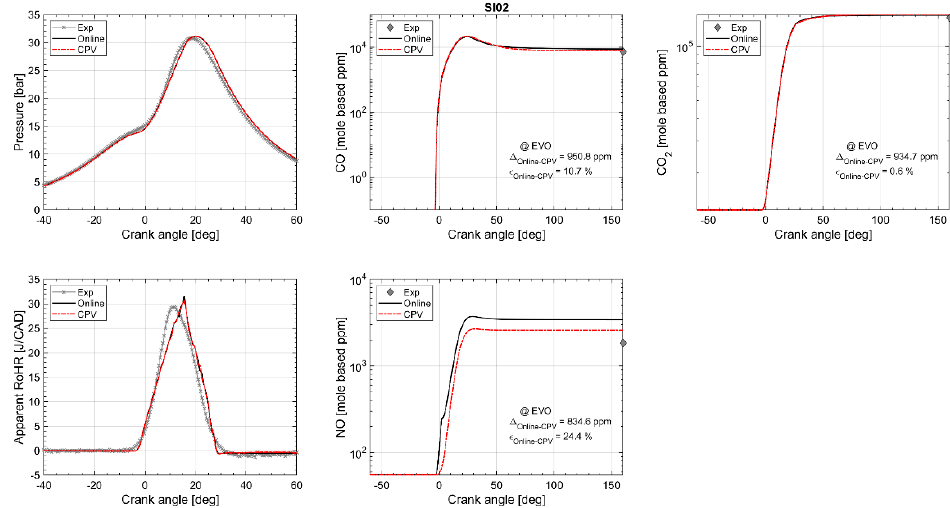
Figure A12. Engine performance and emissions for operating point SI02 (2000 rpm, 5.0 bar IMEP).